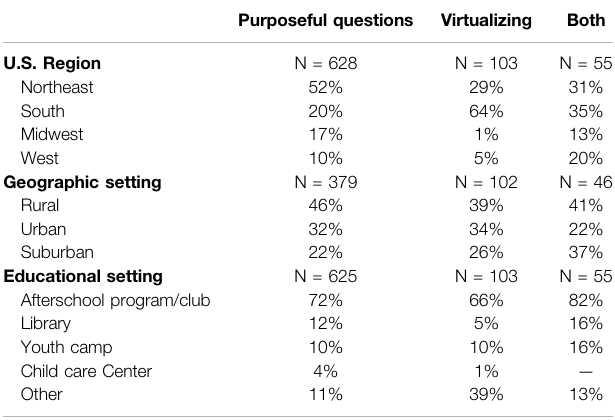
TABLE 2 | ACRES educators by region, geographical and Educational